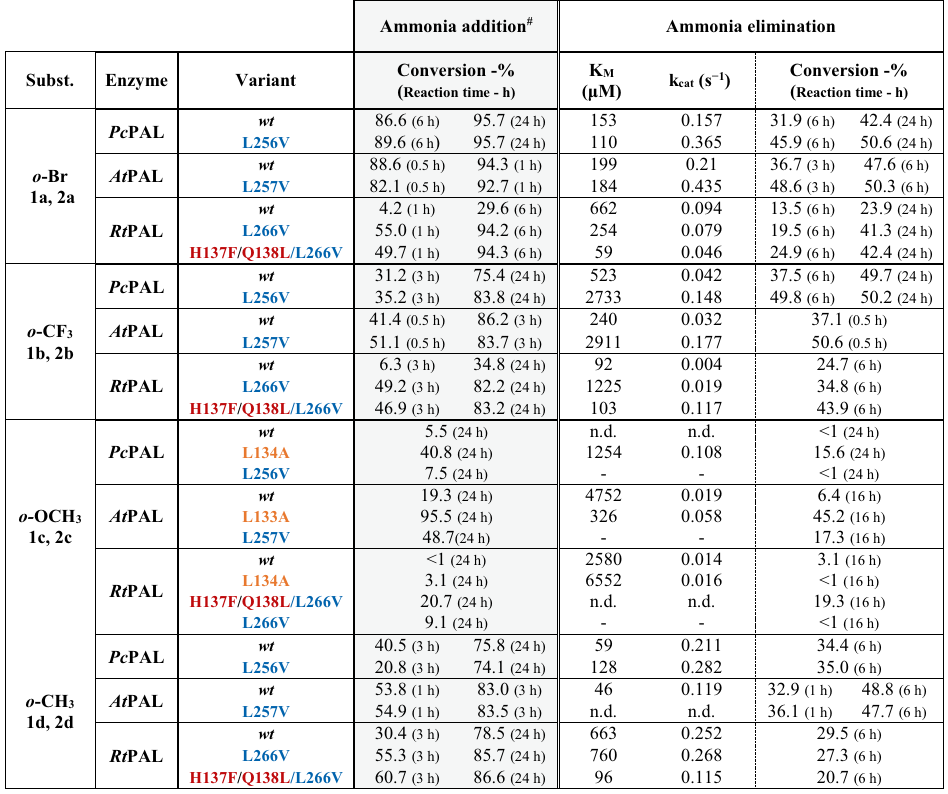
Table 1. Activity assessment of the different PAL variants within the ammonia addition and ammonia elimination reactions of ortho -substituted cinnamic acids 2a–d and rac -phenylalanines 1a–d , respectively. n.d. not determinable, during enzyme kinetics the non-linear range of the Michaelis–Menten curve was not obtained using substrate concentration allowed by the solubility of the tested compounds. # During the ammonia additions the enantiomeric excess of the obtained l-phenylalanine analogues was also monitored, in all cases ee > 99% have been obtained.